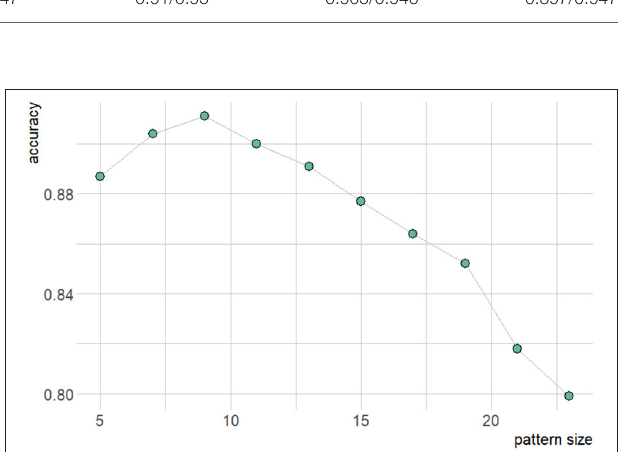
FIGURE 7 | Graph of resulting accuracy dependence on micropattern size for two hidden layers and 1,000